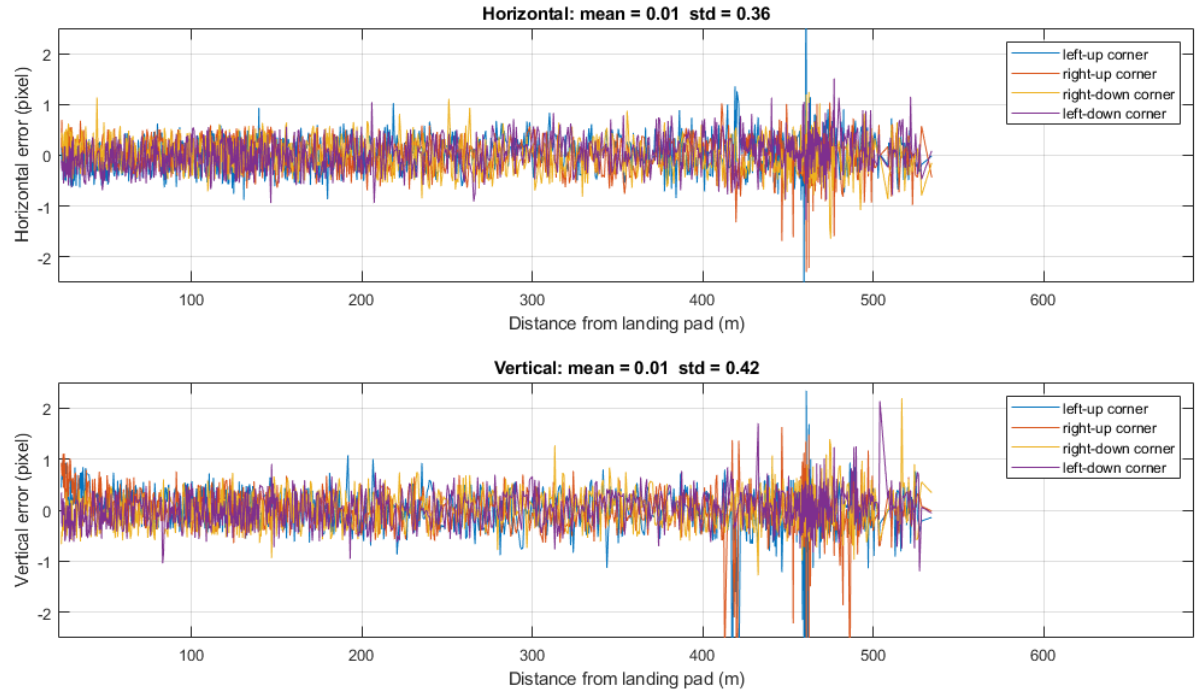
Figure 20. Difference in pixel coordinates of the 4 detected AT corners between image frames collected in the perturbed and in the low − visibility test cases along a VTCA approach trajectory. Corners’ legend is referred to the biggest marker of Figure 6a.